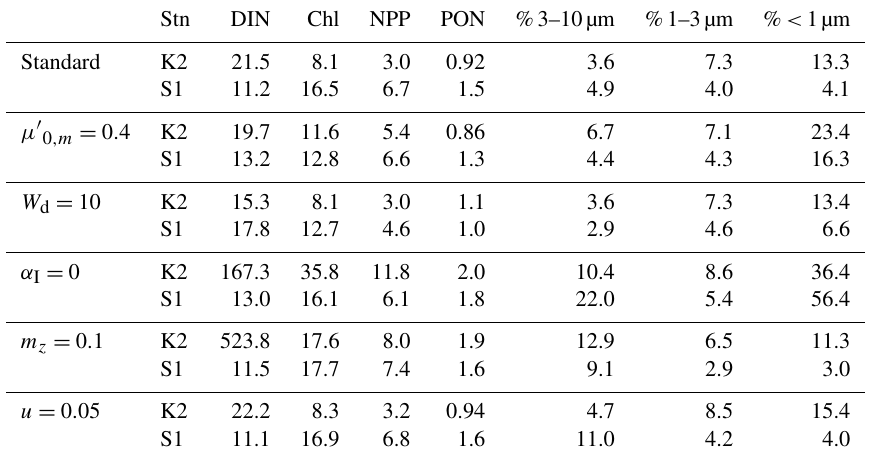
Table 4. Sum of squared errors between model outputs and observational data for sensitivity analysis. The standard run used the optimized parameter values in Table 2. In other runs, only the value of the parameter shown was changed, while others were kept